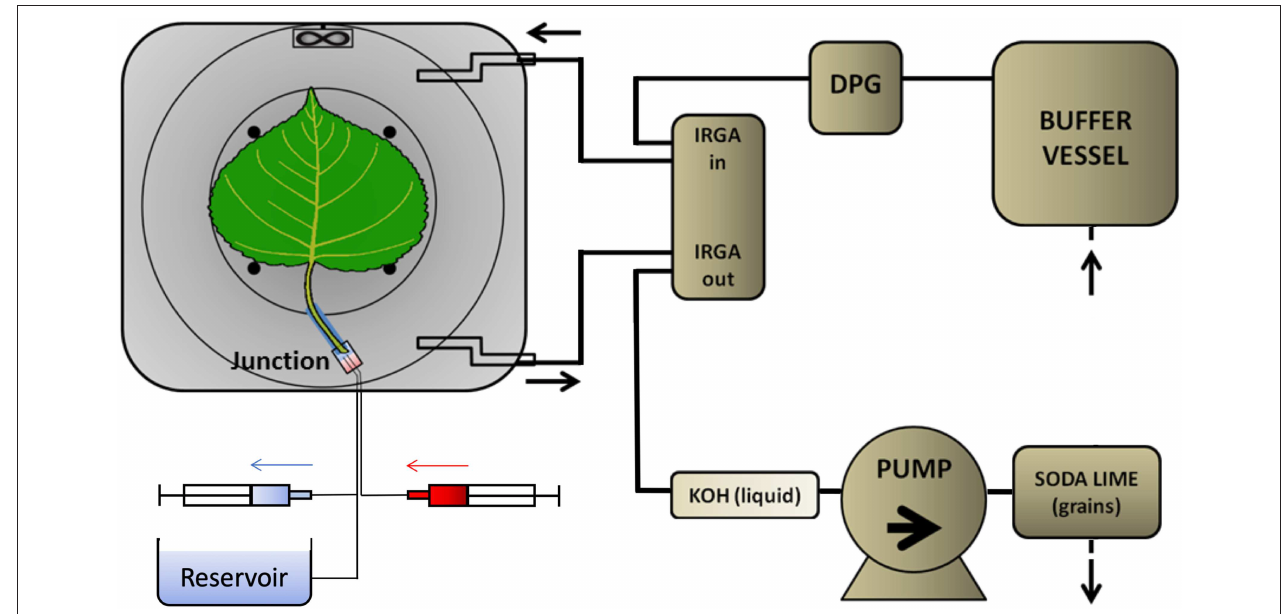
FIGURE 2 | Flow schedule of the PET imaging setup. The PET detectors (dark-gray around the leaf cuvette) were shielded from most of the tubing in which 11 CO 2 was likely present. Ambient air was drawn by a pump that was placed near the end of the pathway to prevent leaks of radioactive gas. The air passed through a 30-L buffer vessel, a dew point generator (DPG), to and from the leaf cuvette via two infra-red gas analyser channels (IRGA), to a KOH trap. As a final safety measure, all air passed from the pump through a granular soda lime trap. The excised leaf received non-labeled solution from a reservoir open to the atmosphere, which was large enough to maintain a constant pressure at the leaf. Tracer was delivered to a small volume in the junction from the 3-mL syringe (red) while simultaneously withdrawing unlabelled solution from the junction into the other syringe (blue). Solution from the reservoir then continued to supply the leaf